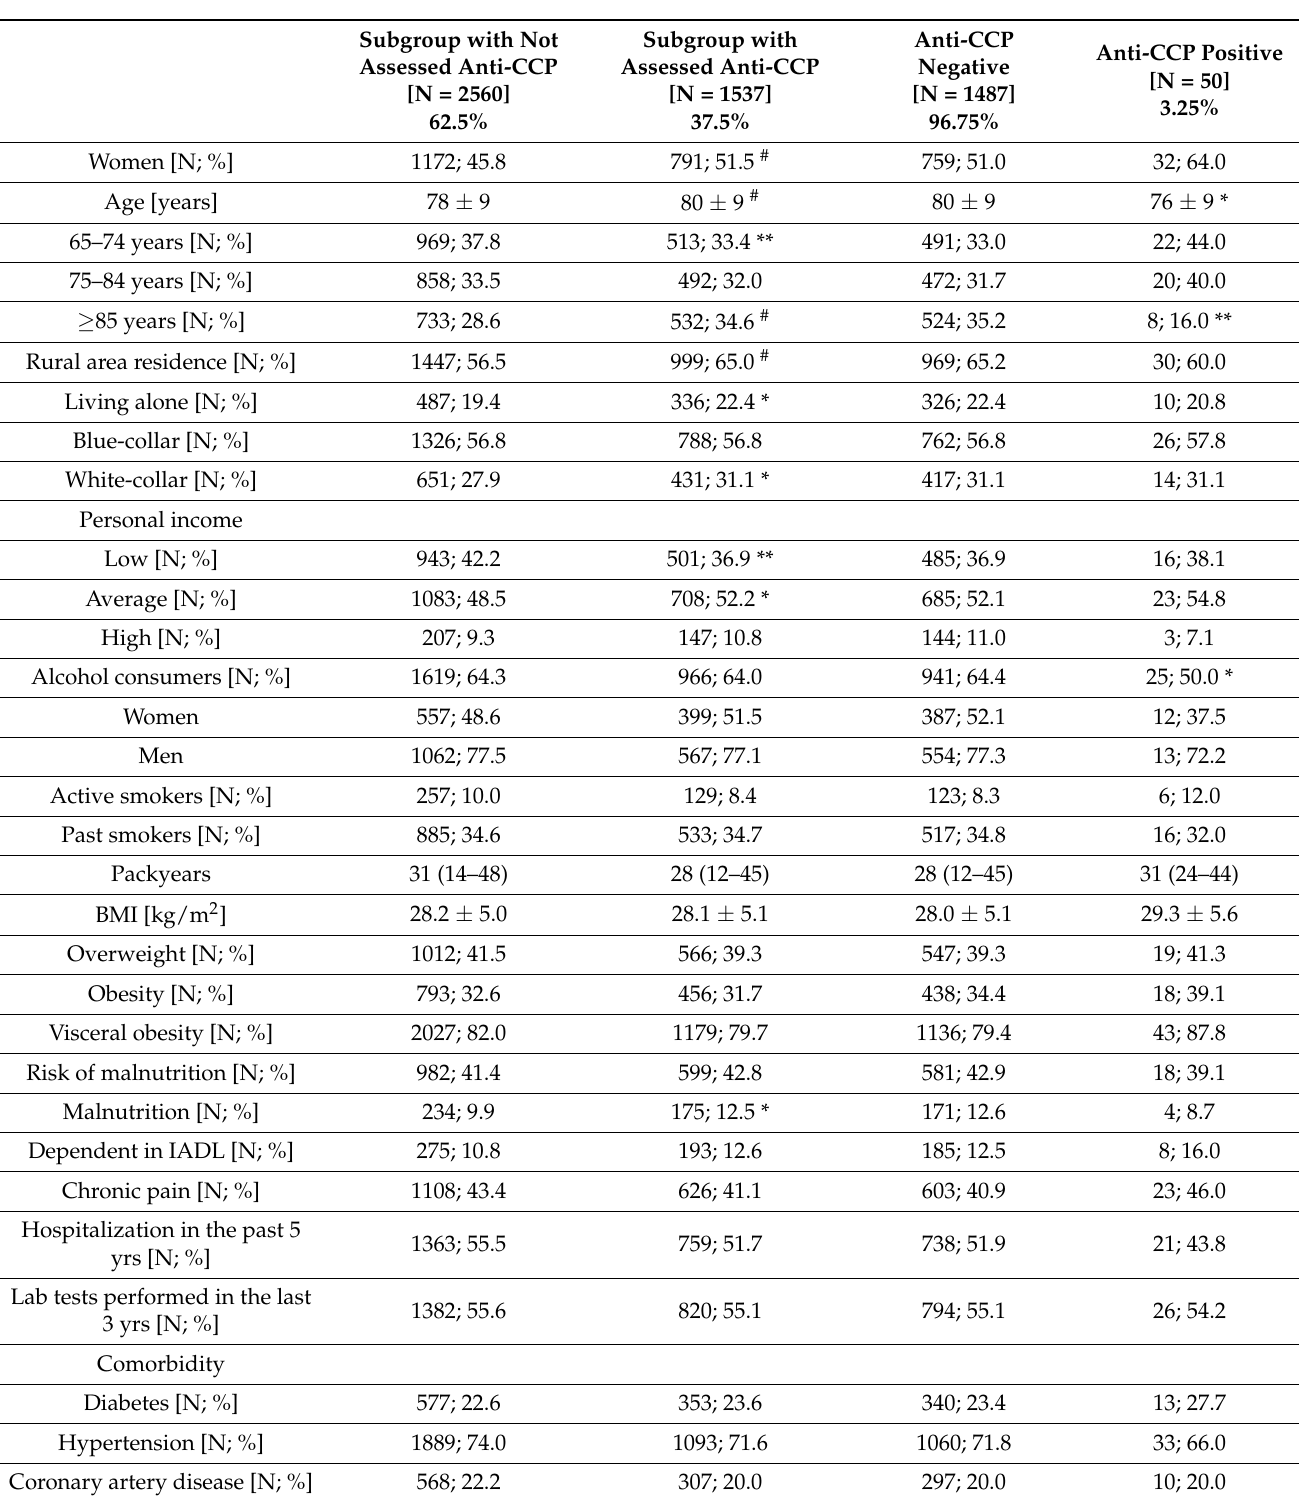
Table 1. Characteristics of study subjects with not assessed and assessed anti-CCP antibodies (including positive and negative subgroups) that were enclosed in the analysis. Subgroup with Subgroup with Not Assessed Anti-CCP Assessed Anti-CCP [N = 1537] [N = 2560] 37.5%